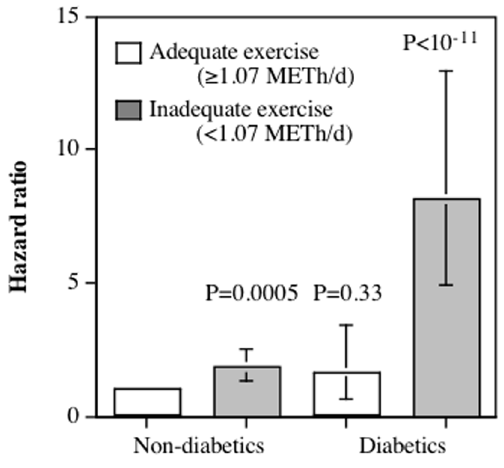
Figure 2. Relative risk of all sepsis-related mortality (sepsis total ) in 133,324 non-diabetics who exercise adequately ( $ 1.07 METh/d), 20,000 non-diabetics who exercise inadequately ( , 1.07 METh/d), 1372 diabetics who exercise adequately, and 788 diabetics who exercise inadequately during an average of 11.6-year mortality surveillance. Brackets designate 95% confi- dence intervals. Relative risks (i.e., the hazard ratios) relative to non- diabetics who exercise adequately were calculated from Cox propor- tional hazard analyses adjusted for sex, age (age and age 2 ), race, and cohort effects. Significance levels correspond to the significance of the risk increase relative to non-diabetics who exercise adequately.